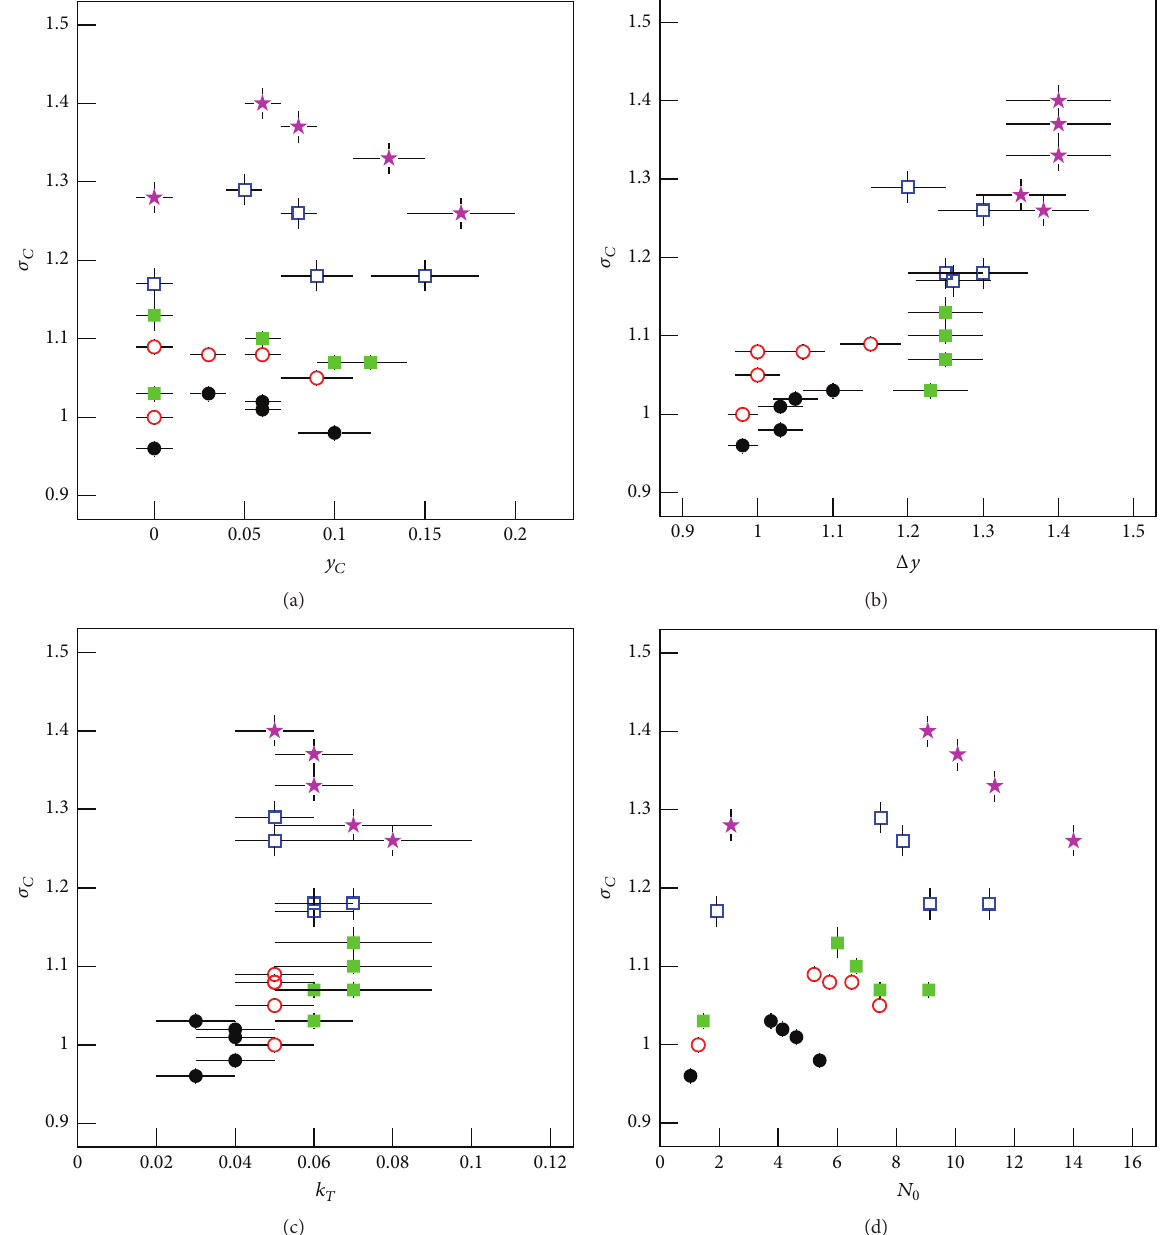
Figure 4: Dependences of 𝜎 𝐶 on (a) 𝑦 𝐶 , (b) Δ𝑦 , (c) 𝑘 𝑇 , and (d) 𝑁 0 . The symbols represent the values listed in Table 1, where the closed circles, open circles, closed squares, open squares, and stars correspond to the collision energy being 6.3, 7.7, 8.8, 12.3 (11.9), and 17.3 (16.8)GeV,